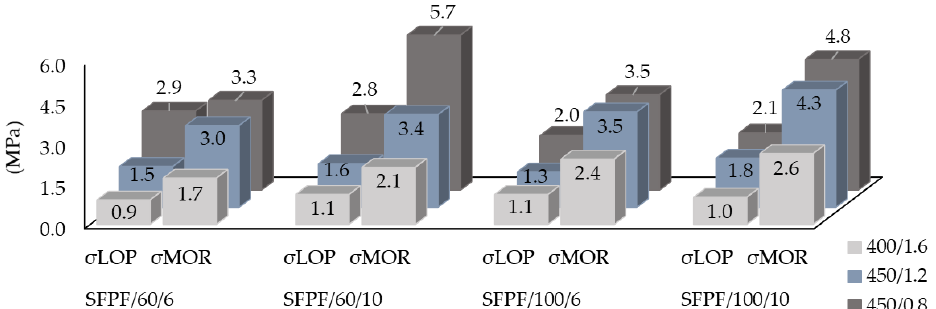
Figure 10. Graphs presenting a combination of σ LOP and σ MOR stress values for fiber-reinforced soil-cements with the addition of SFPF (single fibrillated-tapes polypropylene fibers).